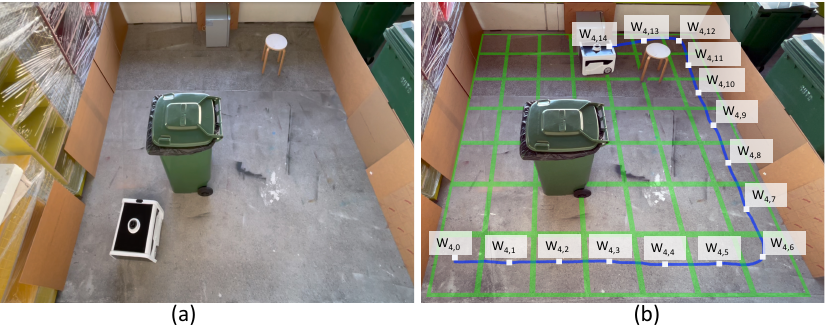
Figure 11. The environment setup for Trial-4 ( a ), and the approximate path traversed and locations visited by the robot ( b